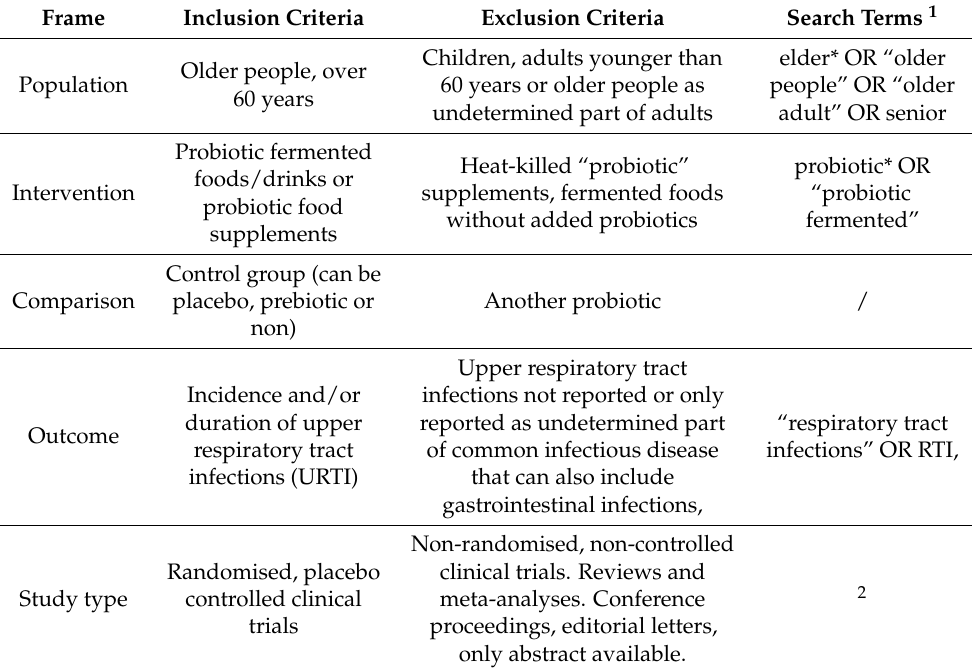
Table 1. Study design according to PICOS framework (population, intervention, comparator outcome, study